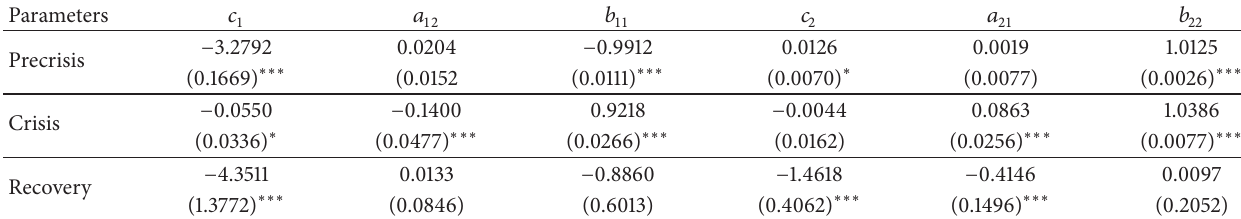
Table 7: Financial contagion analysis between the US and